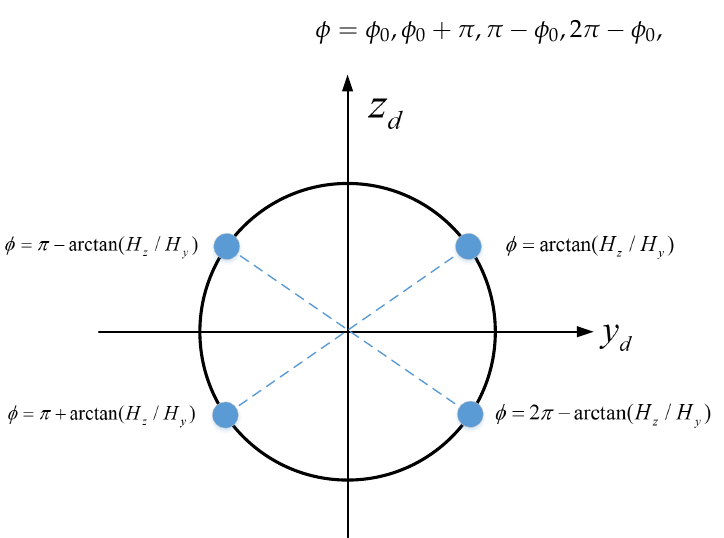
Figure 2. The distribution of four solutions of angle φ in the yoz plane. Since the restriction 2 cos 2 θ − sin 2 θ > 0 is added, the term sin θ cos θ in formulas (10) and (11) will also be positive; thus, according to Formula (10), it is obtained that: